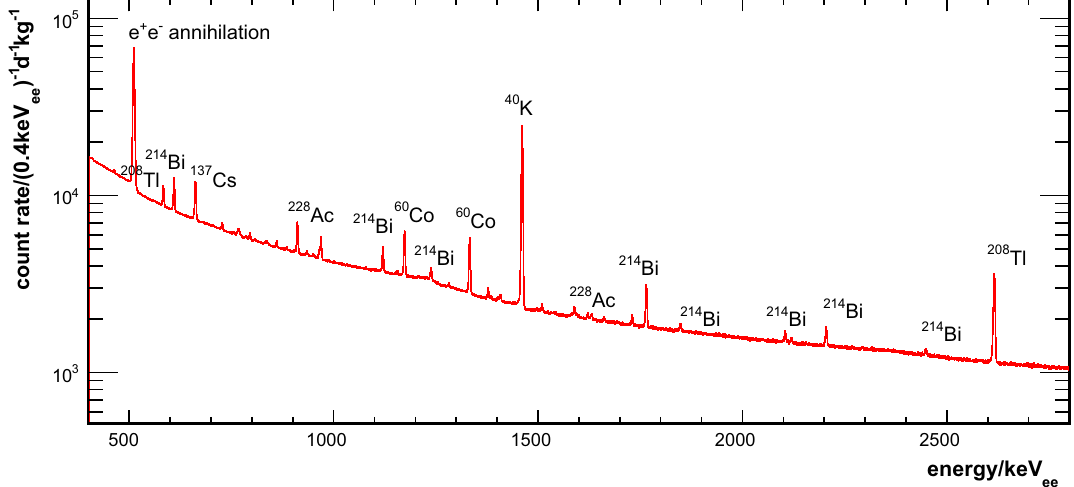
Fig. 21 SpectrumofCONRADdetectorinsideA408withoutanyshieldbelow2700keV.Itisdominatedbynaturalradioactivityinthesurrounding. For the strongest lines except the 511keV line the decaying isotope is given